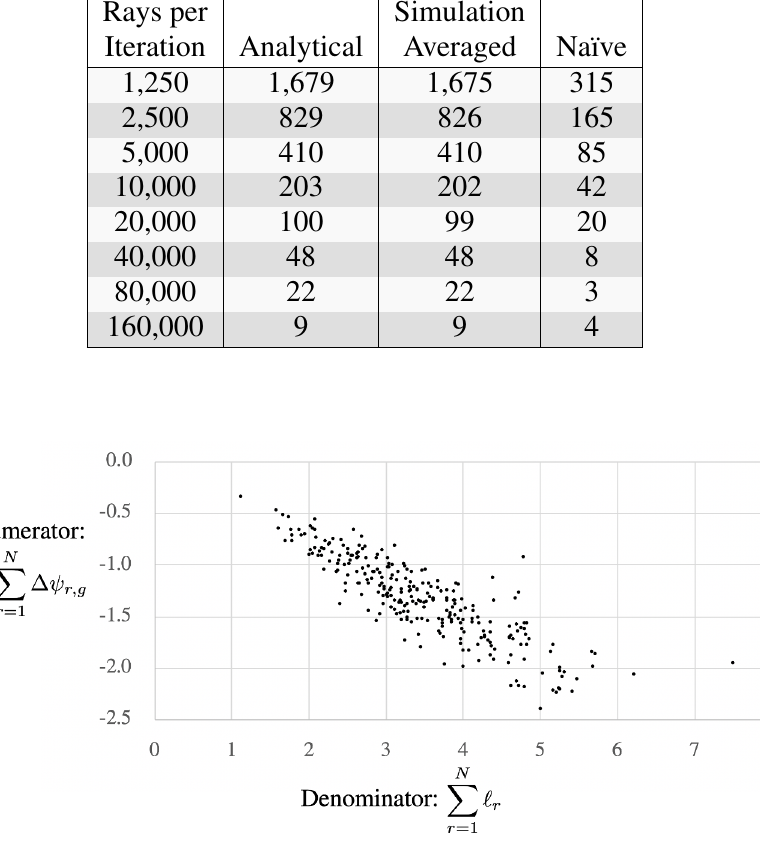
Figure 1: Relationship between the numerator and denominator of Equation 15 of a single FSR and energy group for each active iteration in a test